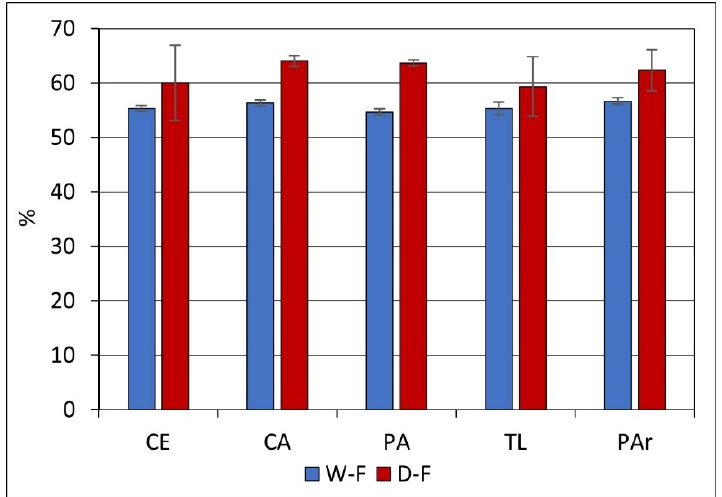
Figure 2. Percentage of methane in biogas produced by both types of fermentation: W–F—wet fer- mentation; D–F—dry fermentation. CE— Carex elata ; CA— Carex acutiformis + Carex elata ; PA— Phrag- mites australis ; TL— Typha latifolia ; PAr— Phalaris arundinacea . Standard errors are shown as vertical bars.